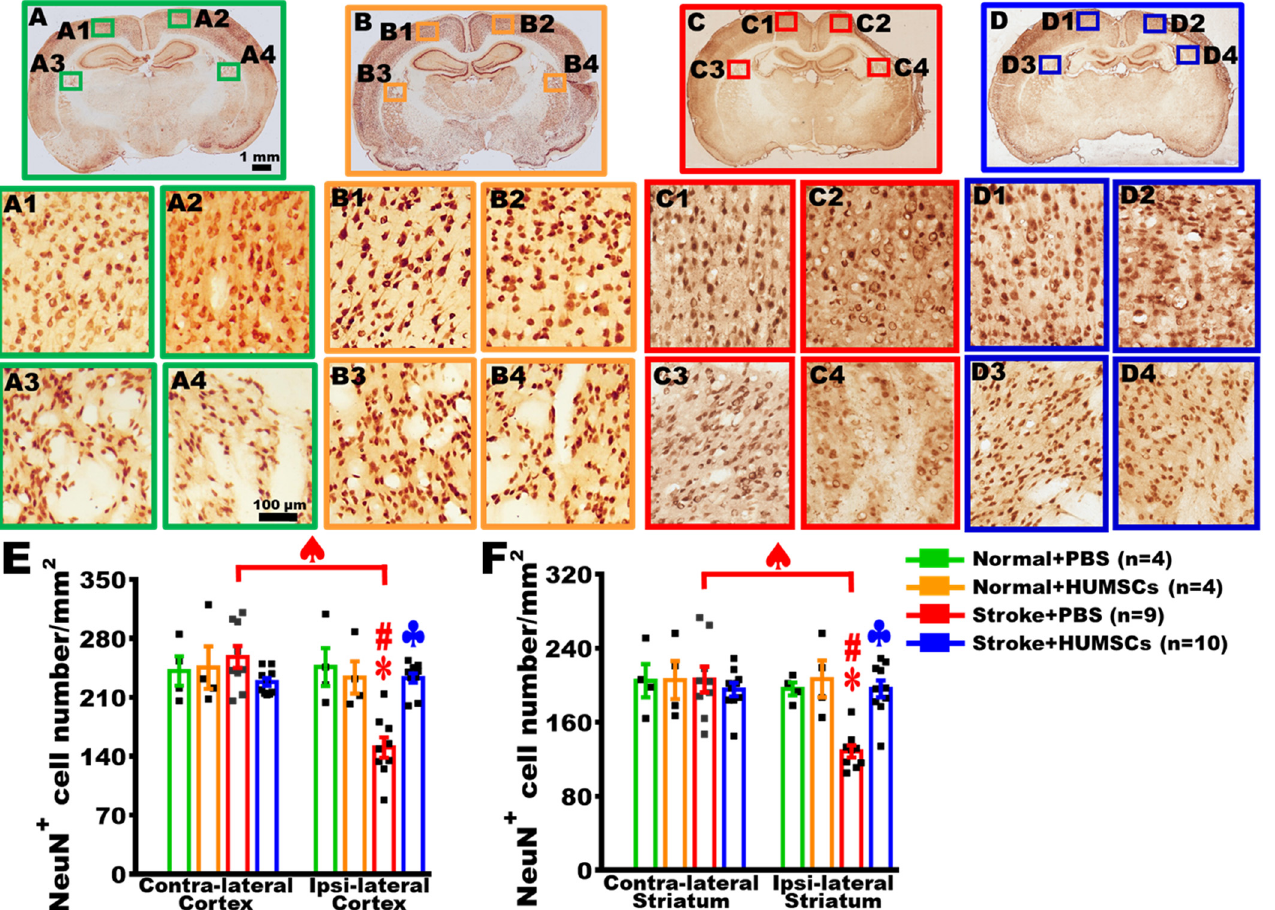
Figure 4. HUMSCs transplantation increased the survival of neuronal cells in the infarcted brain in rats with chronic stroke. On day 56 post stroke, anti-NeuN immunohistochemical staining was applied to observe the number of survived neuronal cells. Brain coronal sections at bregma − 1.92 mm are displayed (( A ): Normal + Saline group; ( B ): Normal + HUMSCs group; ( C ): Stroke + Saline group; ( D ): Stroke + HUMSCs group). For high magnification, the peripheral region to the infarcted cerebral cortex ( A2 , B2 , C2 , D2 ) or striatum ( A4 , B4 , C4 , D4 ) are shown, as well as undamaged contralateral sides of the cerebral cortex ( A1 , B1 , C1 , D1 ) and striatum ( A3 , B3 , C3 , D3 ). The number of NeuN + cells in the cerebral cortex ( E ) and striatum ( F ) was quantified. The results showed that the neuronal cell numbers in the cerebral cortex and striatum peripheral to the damaged brain areas were significantly higher in the Stroke + HUMSCs group than those in the Stroke + Saline group. Normal + Saline n = 4, Normal + HUMSCs n = 4, Stroke + Saline n = 9, Stroke + HUMSCs n = 10. ∗ , vs. the ipsilateral region of Normal + Saline group, p < 0.05. #, vs. ipsilateral region of the Normal + HUMSCs group, p < 0.05. ♣ , vs. ipsilateral region of the Stroke + Saline group, p < 0.05. ♠ , contra-lateral vs. ipsi-lateral region